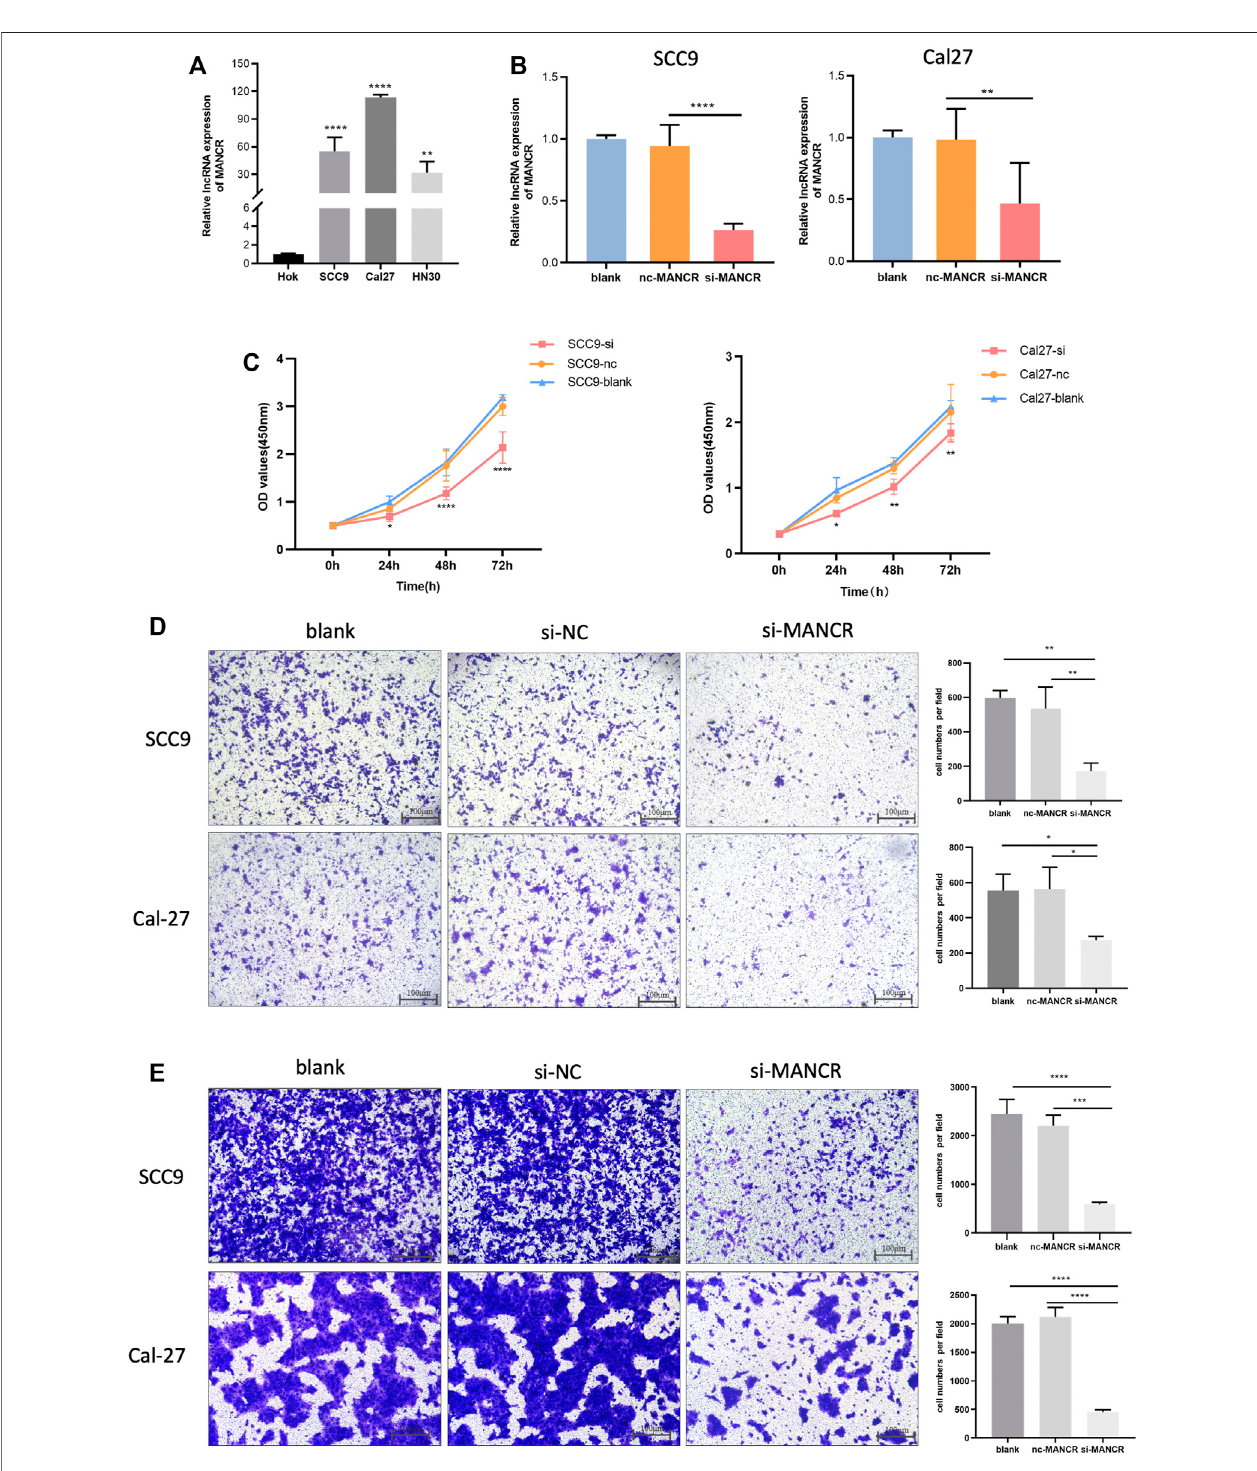
FIGURE7| BiologicaleffectofMANCRonHNSCCcells. (A) ExpressionofMANCRinSCC9,Cal27,HN30,andHokcells. (B) Knockdownef fi ciencywasevaluated by RT-qPCR. (C) Proliferation of Cal27 and SCC9 cells was examined by the CCK-8 assay. (D) Transwell assays were performed and indicated the invasion ability of Cal27 and SCC9 cells. (E) Migration ability of Cal27 and SCC9 cells were also examined by the transwell assay (* p < 0.05, ** p < 0.01, *** p < 0.001, and **** p < 0.0001).